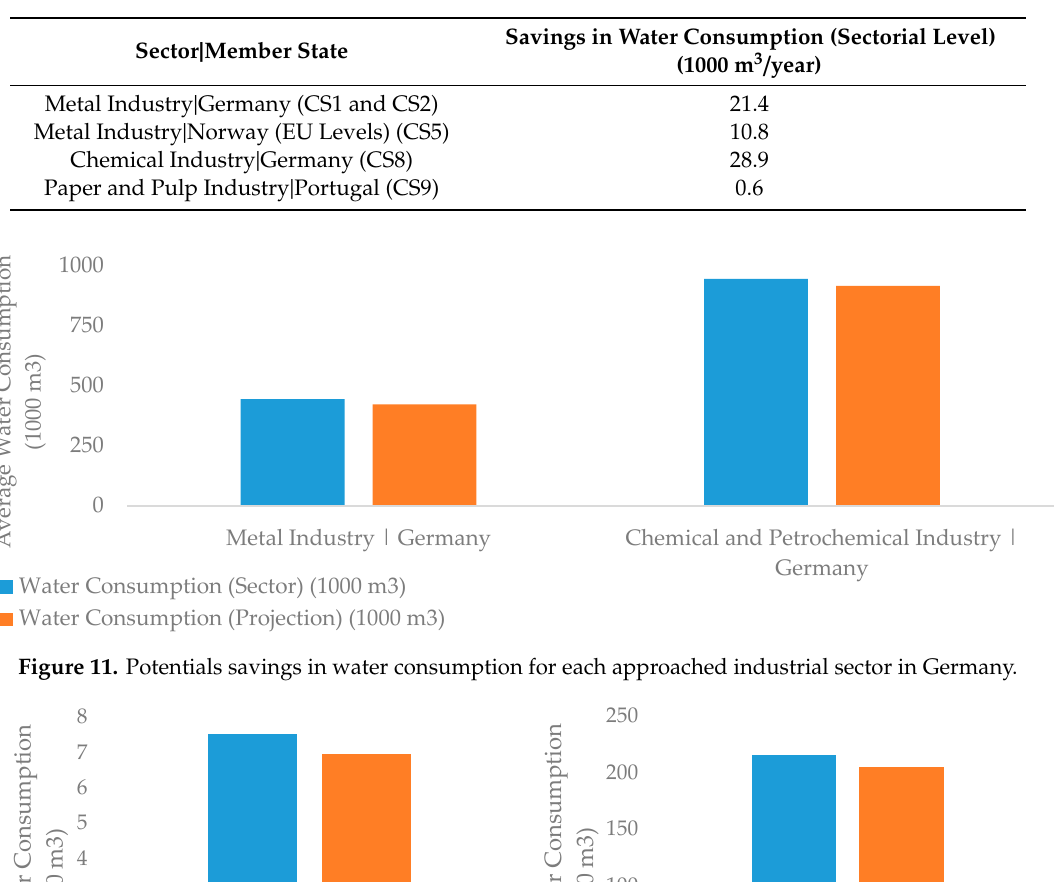
Table 14. Potential savings in water consumption in each industrial sector at EU level.